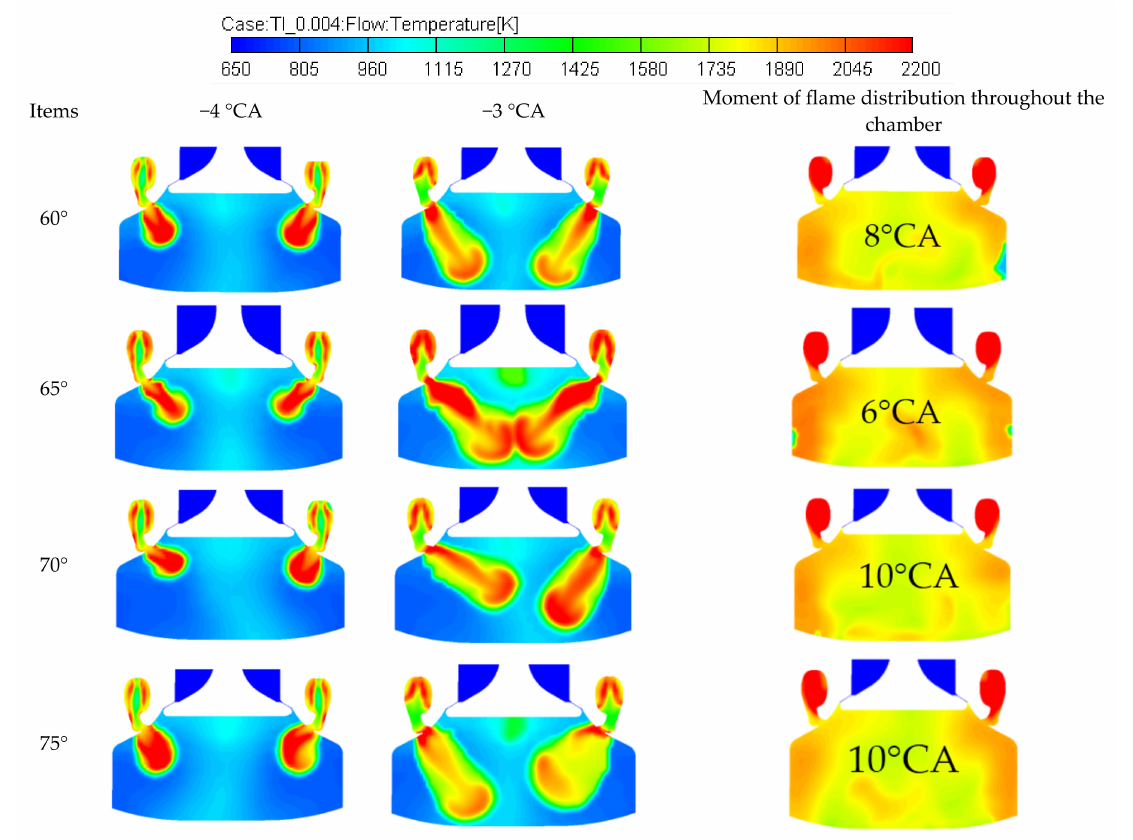
Figure 15. Flame distribution in the combustion